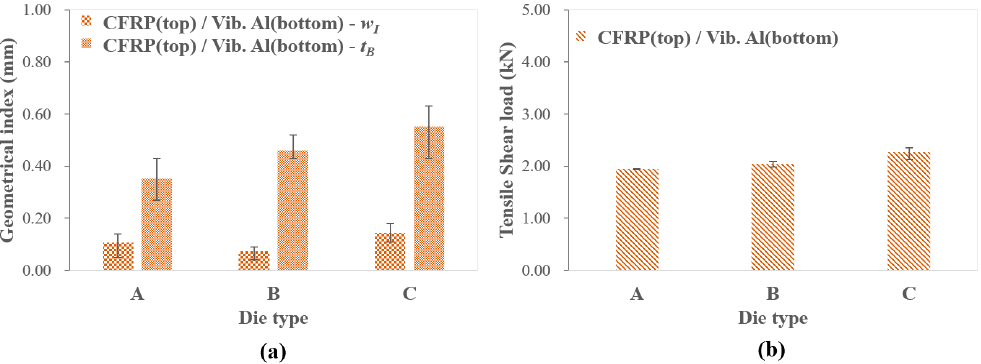
Figure 13. ( a ) Interlock width and bottom thickness, and ( b ) tensile shear loads for the self-piercing riveted joint formed between vibration-damping Al and CFRP with respect to the die type.